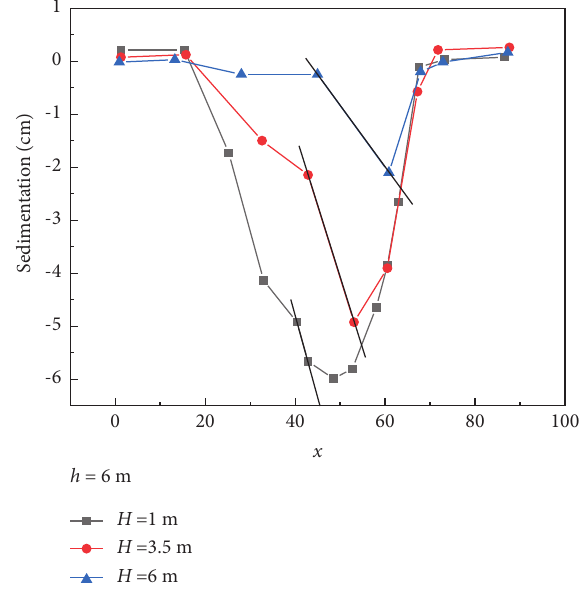
Figure 11: The foundation settlement curve corresponding to different existing embankment